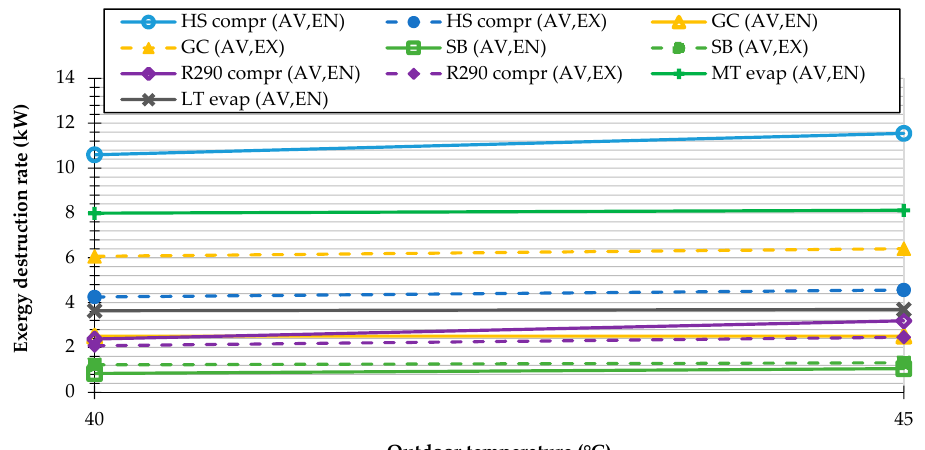
Figure 10. Effect of the outdoor temperature on the avoidable and unavoidable exergy destruction rates of the investigated system.